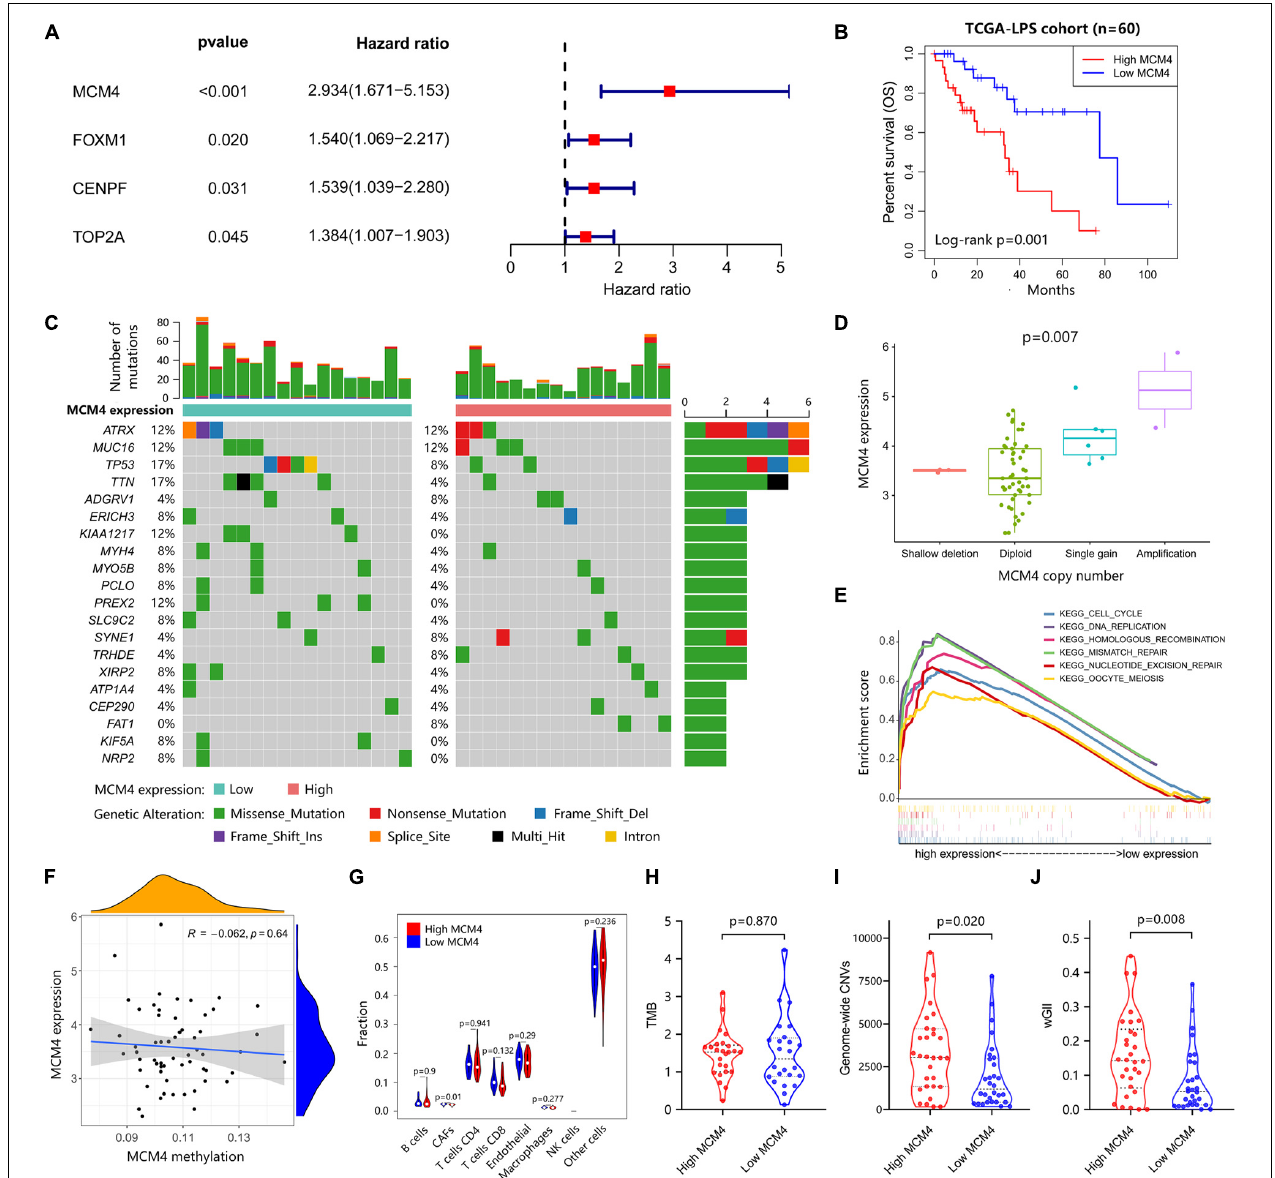
FIGURE 2 | Integrated genomic characterization of the MCM4-high and MCM4-low expression subgroup of LPS in TCGA ( n = 60). (A) The four hub genes were investigated using the univariate Cox-regression analysis. The hazard ratio and the 95% confidence interval of each gene were shown in forest map. (B) The overall survival of the MCM4-high subgroup is significantly worse than that of the MCM4-low subgroup in LPS with Log-rank test p < 0.001. (C) The landscape of somatic mutations between MCM4 high- and low-expression LPS demonstrated recurrent mutations in ATRX, MUC16, TP53, etc. There was no significant difference in the frequency of the somatic mutations between the two groups ( t -test, p > 0.05). (D) The MCM4 expression of LPS tumor samples was significantly affected by the copy-number variations of MCM4 (Kruskal–Wallis, p = 0.007). (E) The KEGG pathways enrichment analysis indicated that the transcriptome of the MCM4-high vs. the MCM4-low subset was different in several pathways, including the cell cycle, DNA replication and multiple DNA damage repair gene sets. (F–H) The tumor mutation burden (TMB) ( t -test, p = 0.870), MCM4 methylation (Spearman’s correlation, p = 0.640), and immune cell infiltration (Wilcoxon test, p > 0.05; except for CAFs) were minimally different between the MCM4-high and MCM4-low LPS. In contrast, the MCM4-high LPS exhibited a higher level of genomic instability than the MCM4-low counterpart, as indicated by genome-wide copy number variations (CNV) burden [ (I) ; Wilcoxon test, p = 0.020] as well as the weighted Genome Instability Index score [ (J) ; Wilcoxon test, p =